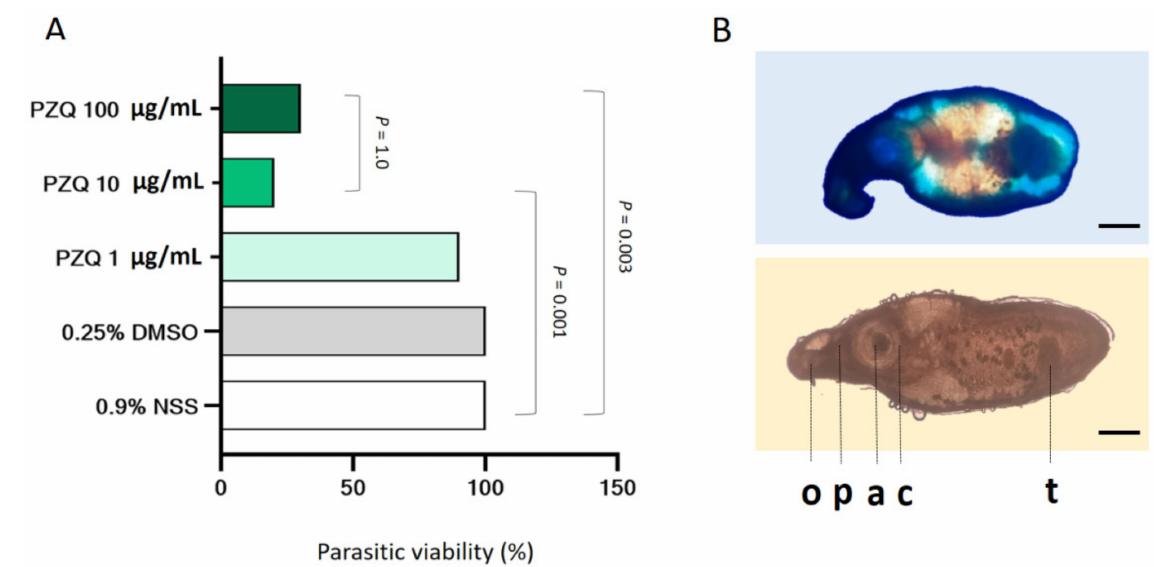
Figure 1. Dose-response parasiticidal activity of PZQ in P. gralli. The parasites were treated with a series of concentrations in the range 1–100 µ g/mL for 24 h. ( A ) Data represent the percentages of parasitic viability ( n = 10 per group). Experimental data were analyzed using the chi squared test. Significant p -values was highlighted onto the comparable bars ( B ) A non-viable parasite stained with vital dye of 1% w / v methylene blue (panels on the top side) and a viable parasite (panels on the bottom side) The scale bars represent 500 microns Features noted here include the oral sucker ( o ), pharynx ( p ), cirrus pouch ( c ), acetabulum ( a ), and testes ( t ).